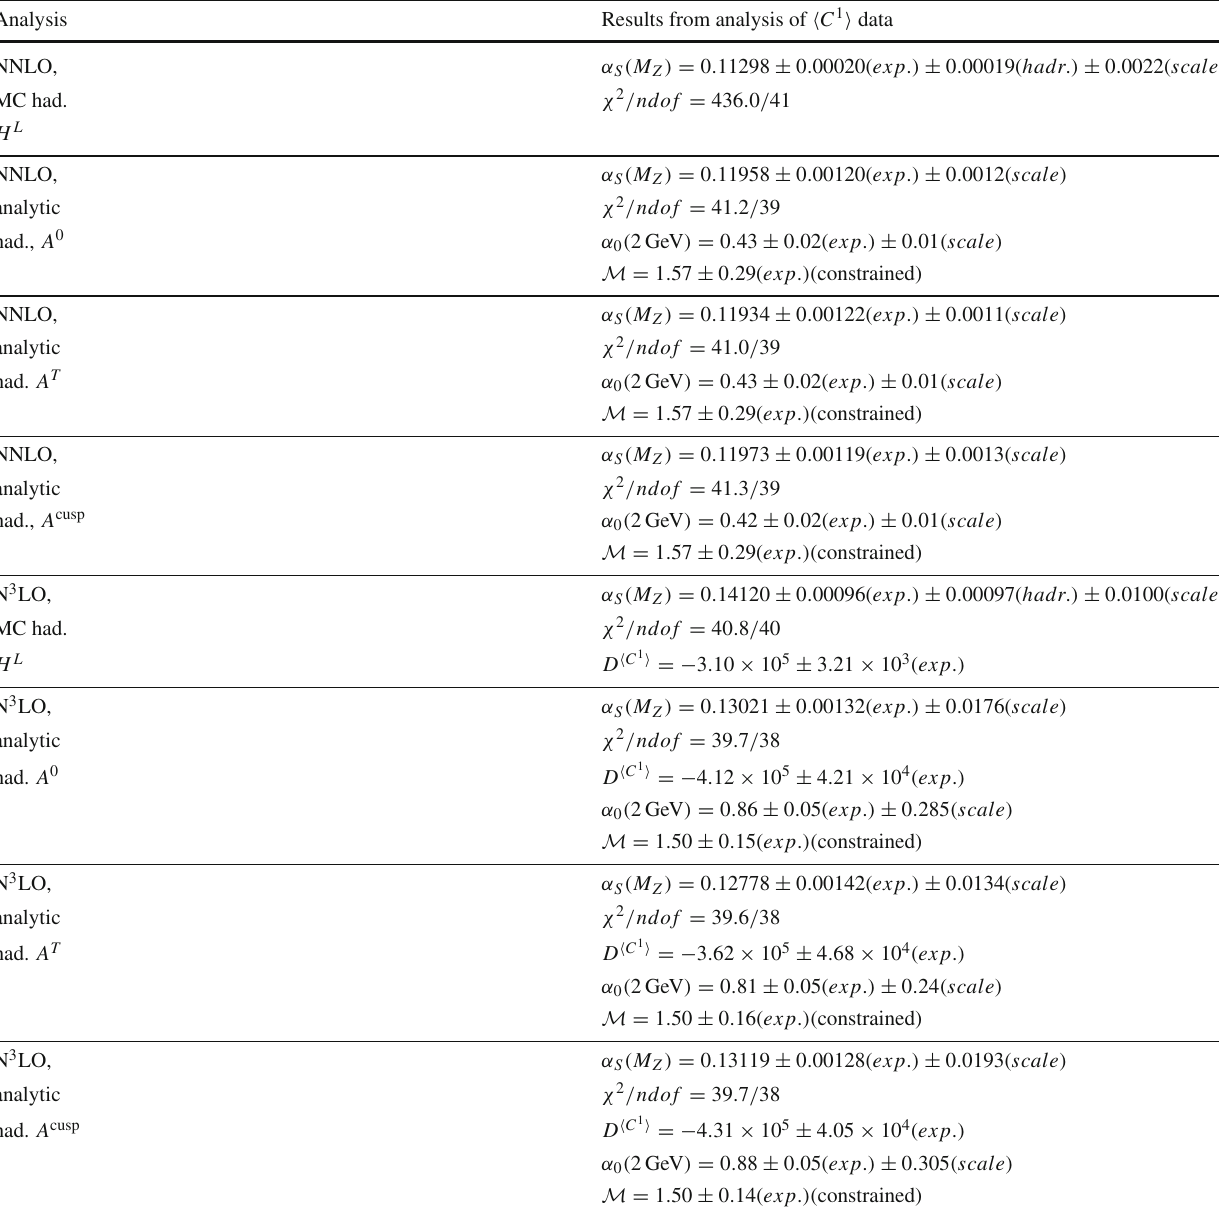
Table 4 Results of the extraction analyses using the (cid:2) C 1 (cid:3) observable Analysis Results from analysis of (cid:2) C 1 (cid:3) data